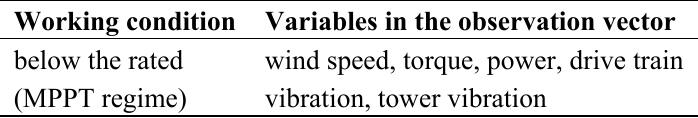
Table 2. Observation vector below rated wind speed.